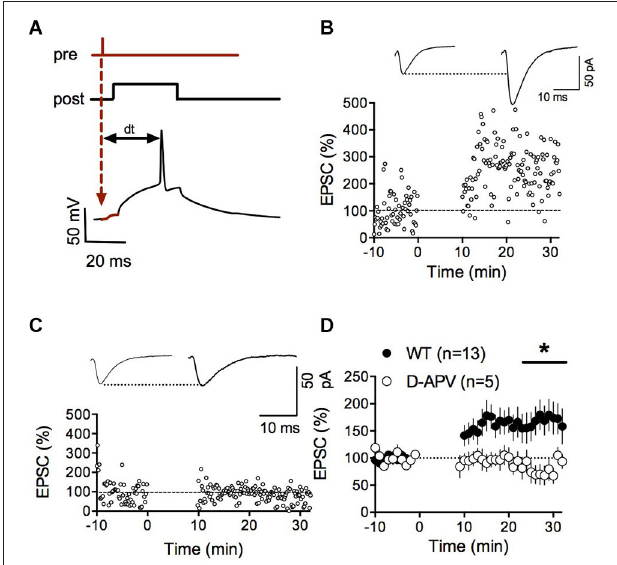
FIGURE 1 | NMDAR-dependent spike timing-dependent potentiation (LTP) in accumbens medium spiny neurons. (A) Schematic representation of the pre-post protocol used to induce LTP. After the presynaptic stimulation the postsynaptic cell was depolarized for 30 ms to elicit an action potential. The time delay between presynaptic stimulation and the elicited spike was set to 25 ms. (B) Representative experiment illustrating the induction of LTP. Inset shows EPSCS sampled during the 10 min baseline and 20 min after LTP induction respectively. (C) Representative experiment showing that LTP in WT mice was abolished by the application of the NMDAR-antagonist D-APV (50 µ M). (D) Summary of LTP experiments with (white circles) and without D-APV (black circles). LTP was blocked by application of 50 µ M D-APV ( p = 0.0441 Mann-Whitney